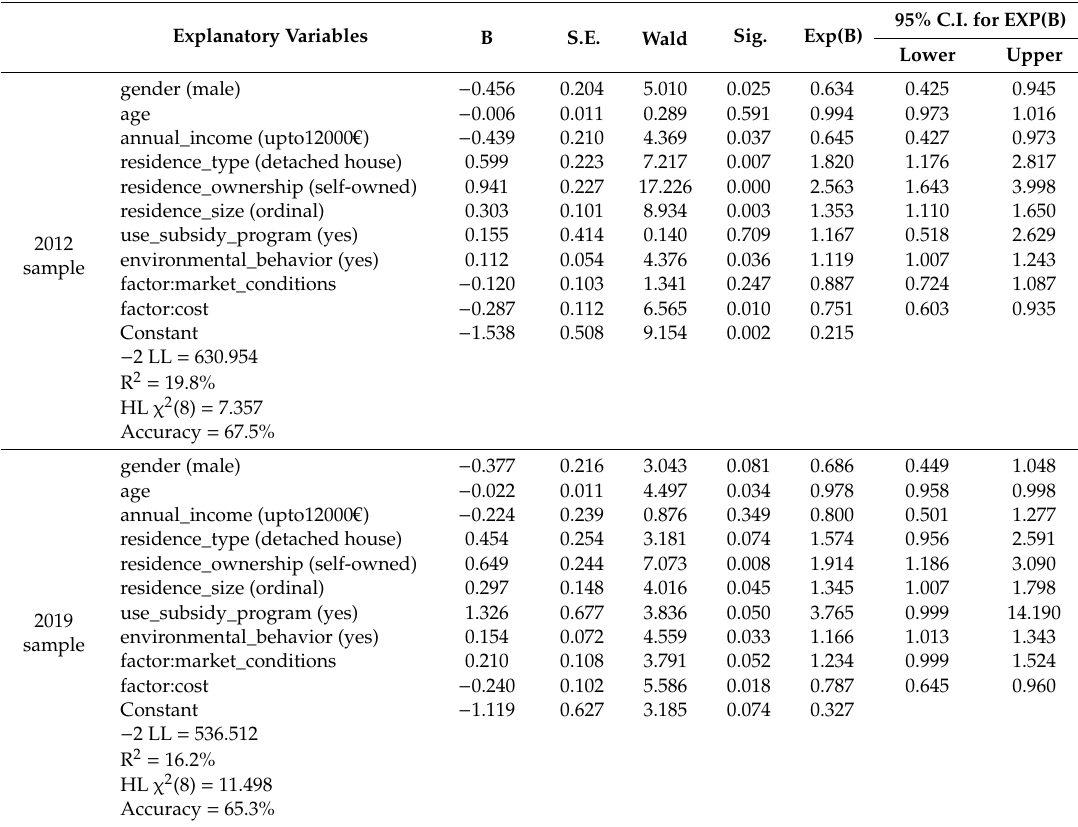
Table 4. Logistic regression models on real decisions on the installation of residential microgeneration